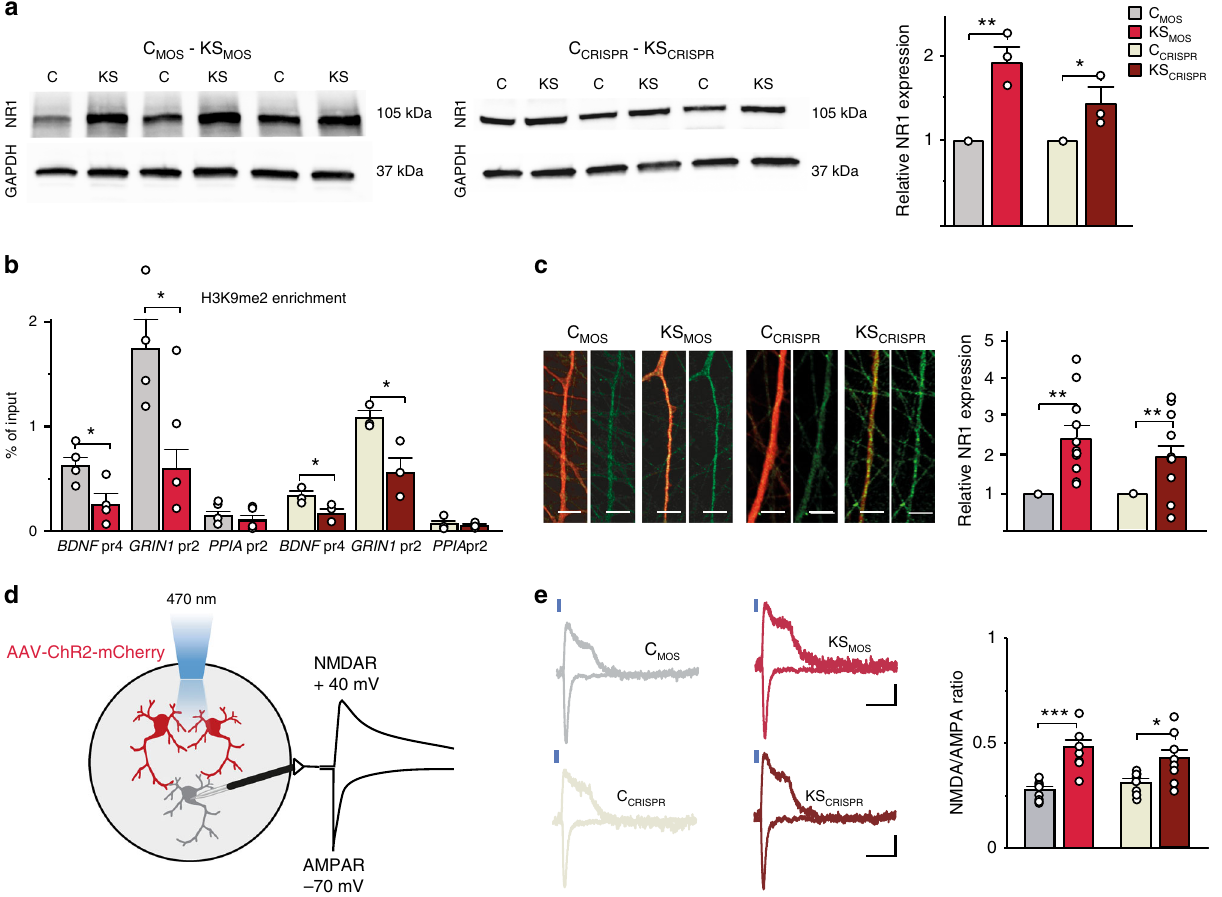
Fig. 5 NMDA receptor subunit 1 is upregulated in KS patient-derived neurons. a Representative western blots and graph showing the NR1 protein levels in control and KS iNeurons at DIV 28. Values of KS MOS are normalized to C MOS and values of KS CRISPR are normalized to C CRISPR ( n = 3). b ChIP assay of H3K9me2 followed by promoter-speci fi c (BDNF_pr4, GRIN1_pr2, and PPIA_pr2) qPCR performed in iNeurons from C MOS , KS MOS , C CRISPR , and KS CRISPR ( n = 4 for mosaic lines and n = 3 for crispr lines). c Representative images showing NR1 expression and quanti fi cation for C MOS , KS MOS , C CRISPR , and KS CRISPR ( n = 12). d Schematic representation of methodology to obtain the AMPA and NMDA ratio. e Representative traces and quanti fi cation of NMDA/AMPA ratio for C MOS , KS MOS , C CRISPR , and KS CRISPR ( n = 8). Blue bars indicate light stimulus. Scale bar 100ms, 10pA. Data represent means±SEM. * P <0.05, ** P <0.005, *** P <0.0005, one-way ANOVA test and post hoc Bonferroni correction was performed between conditions. Source data is available as a Source Data fi